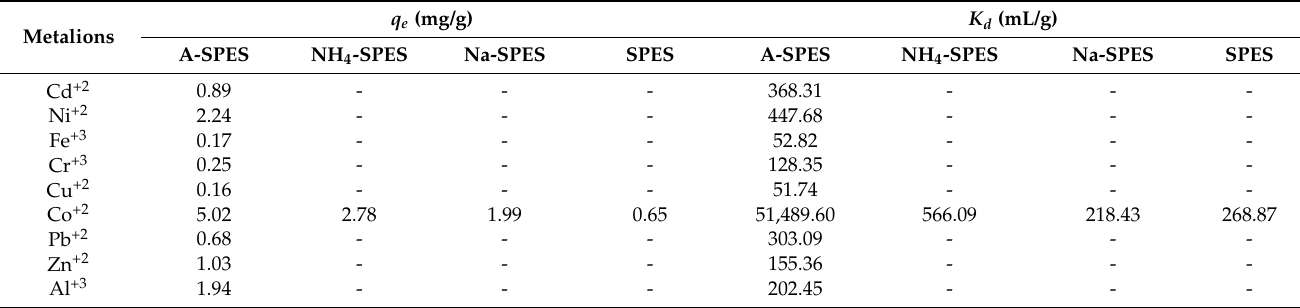
Table 2. Study of the selectivity on the adsorption of SPES, Na-SPES, NH 4 -SPES, and A-SPES against different metal ions at 25 ◦ C (N =